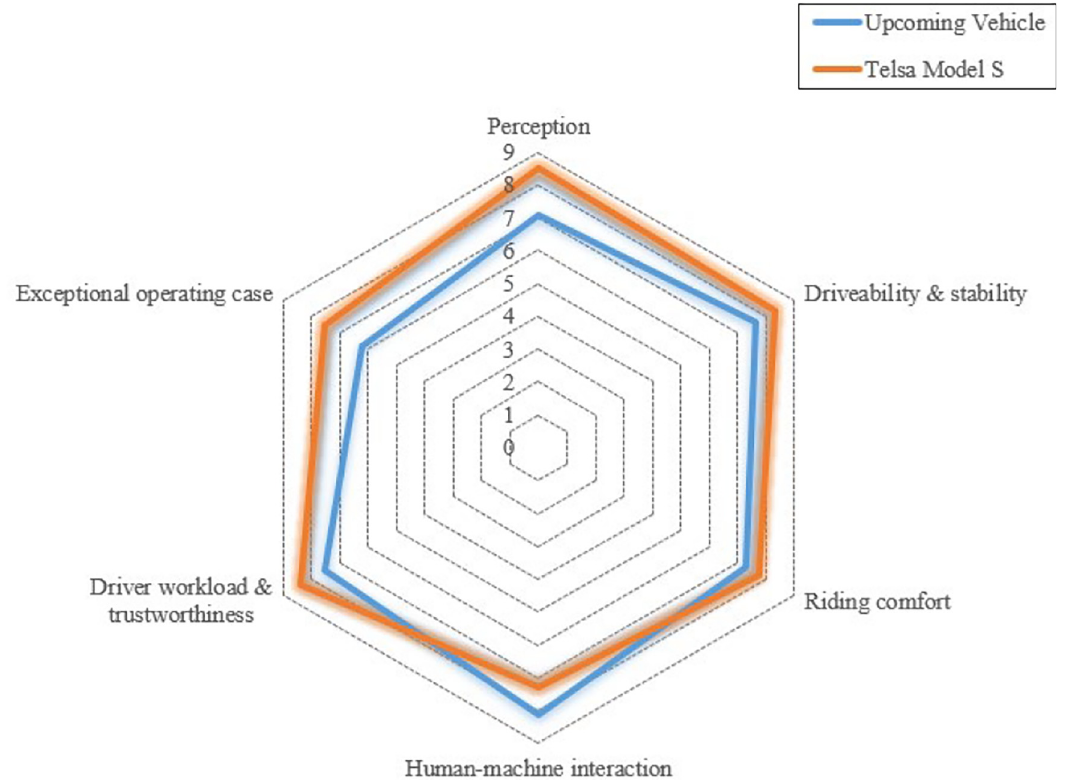
Figure 5 Comparison of the subjective assessment results for two